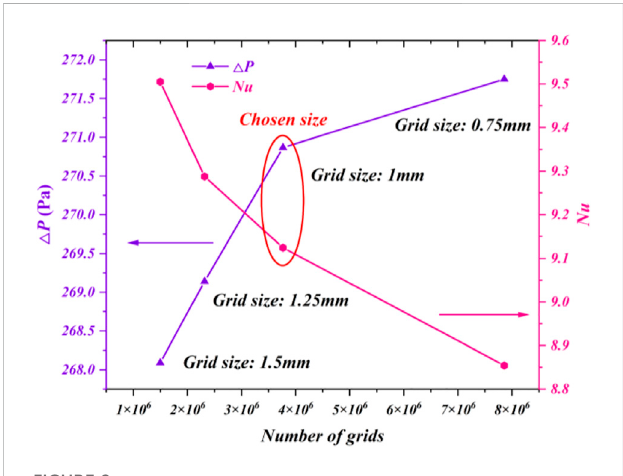
FIGURE 2 Grid-independence veri fi cation. The pink and purple lines represent the Nu and pressure drop, respectively.